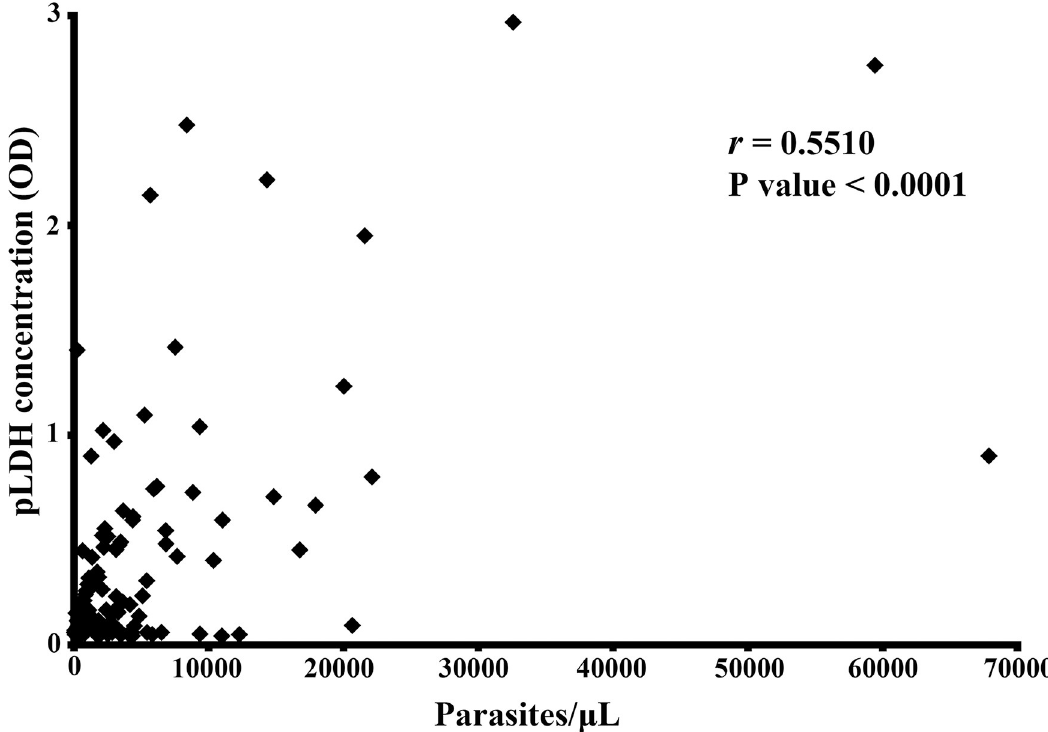
Fig 1. Correlations between parasite density and pLDH levels among Plasmodium ovale isolates (r =